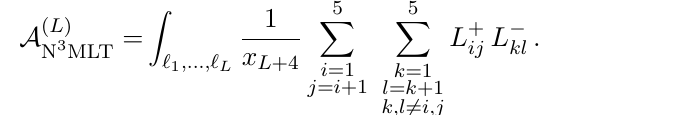
appear with combinations of other λ ± tuples of length three.